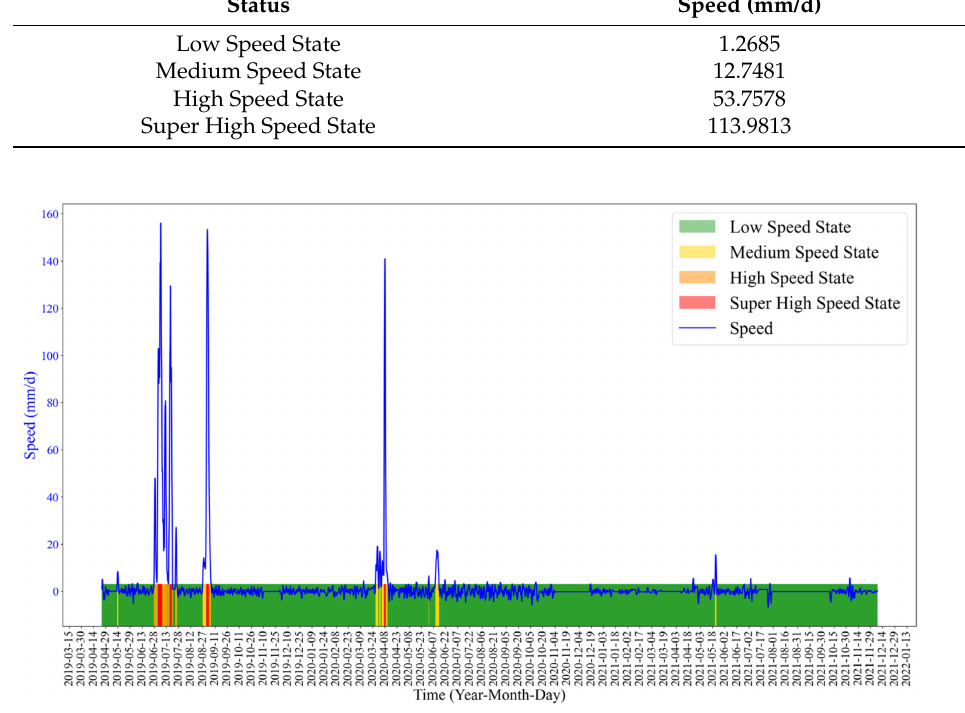
Figure 7. Clustering